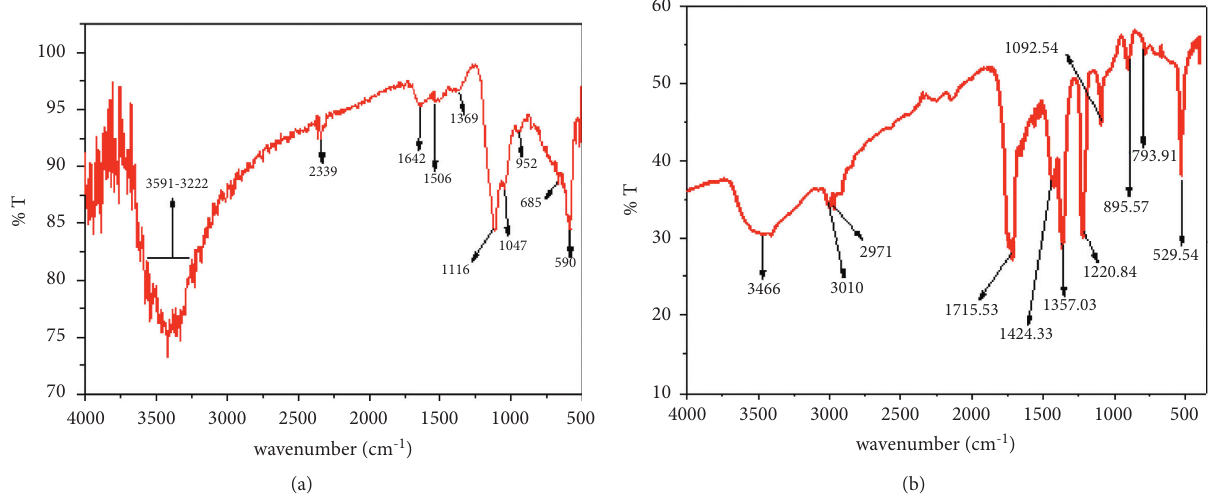
Figure 1: (a) FTIR spectrum of NiO-ZnO NC and (b) FTIR spectrum of D. kaki .